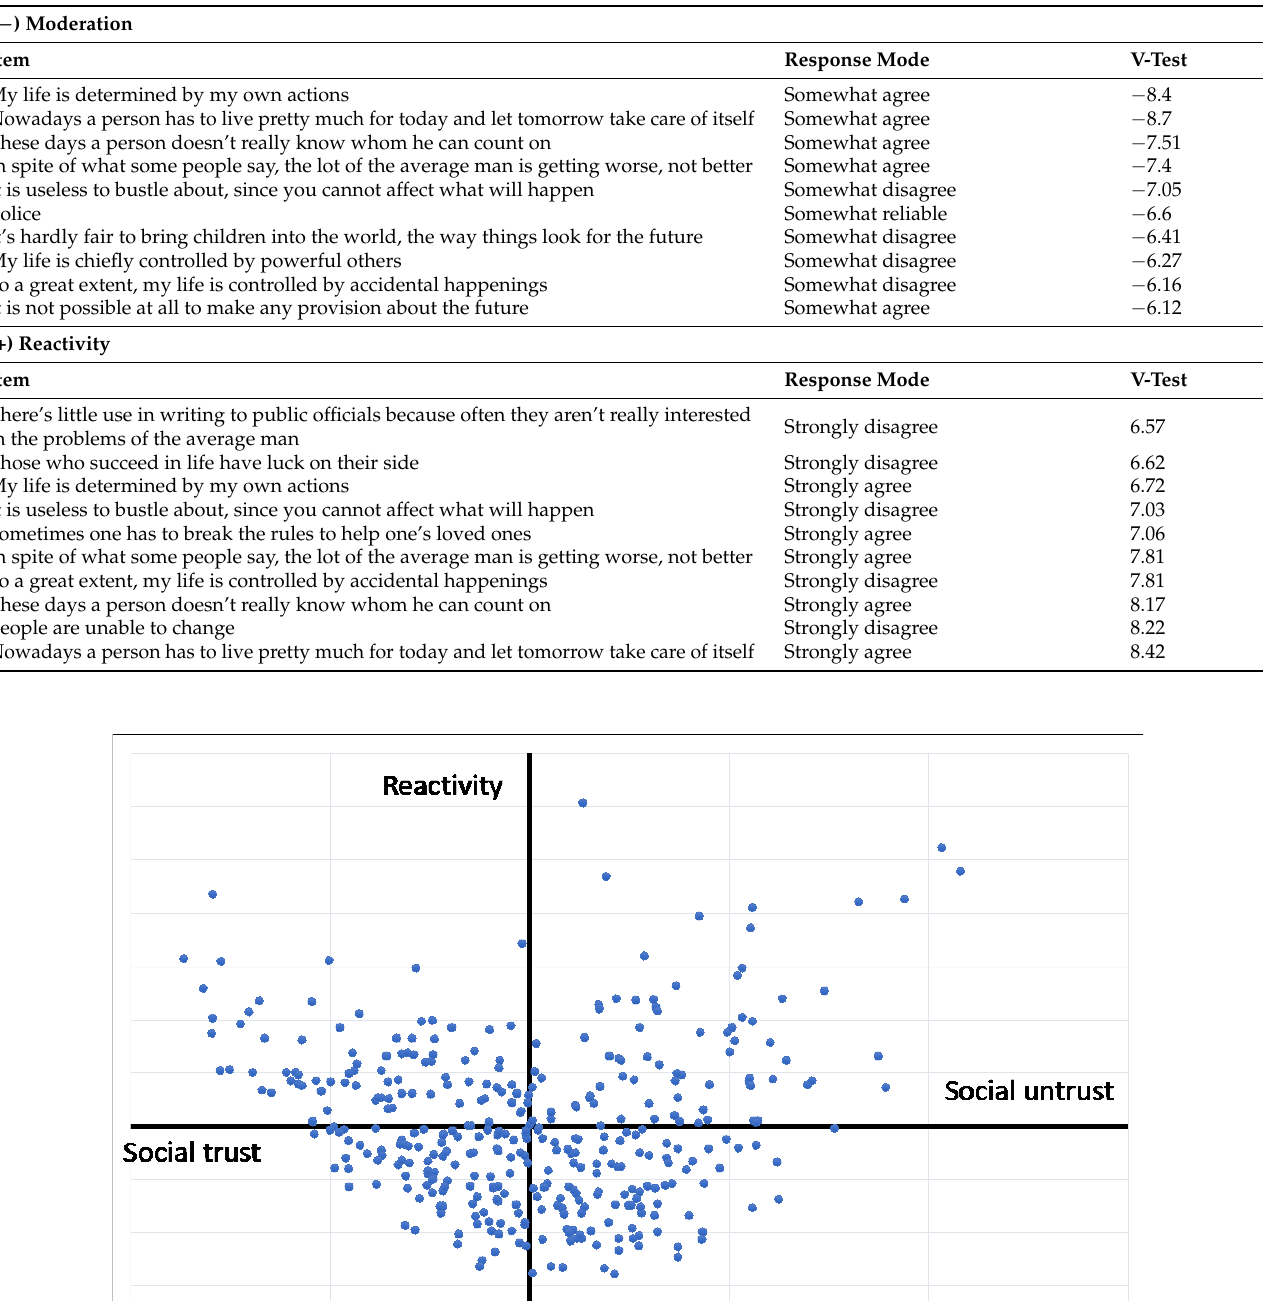
Table 2. Response modalities associated to the first factorial dimension (VOC 1).